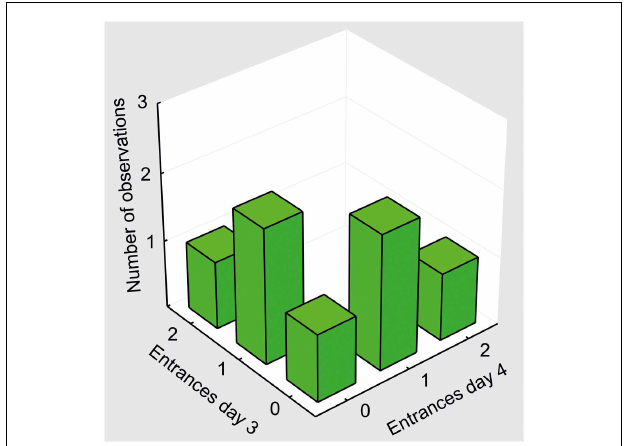
FIGURE 9 | Behavioral pattern in control animals (sal/MK10) . A bivariate histogram for the number of Entrances on days 3 and 4. No rat entered the shock zone in both sessions. One entrance in one of the sessions was the most typical performance in the control group.